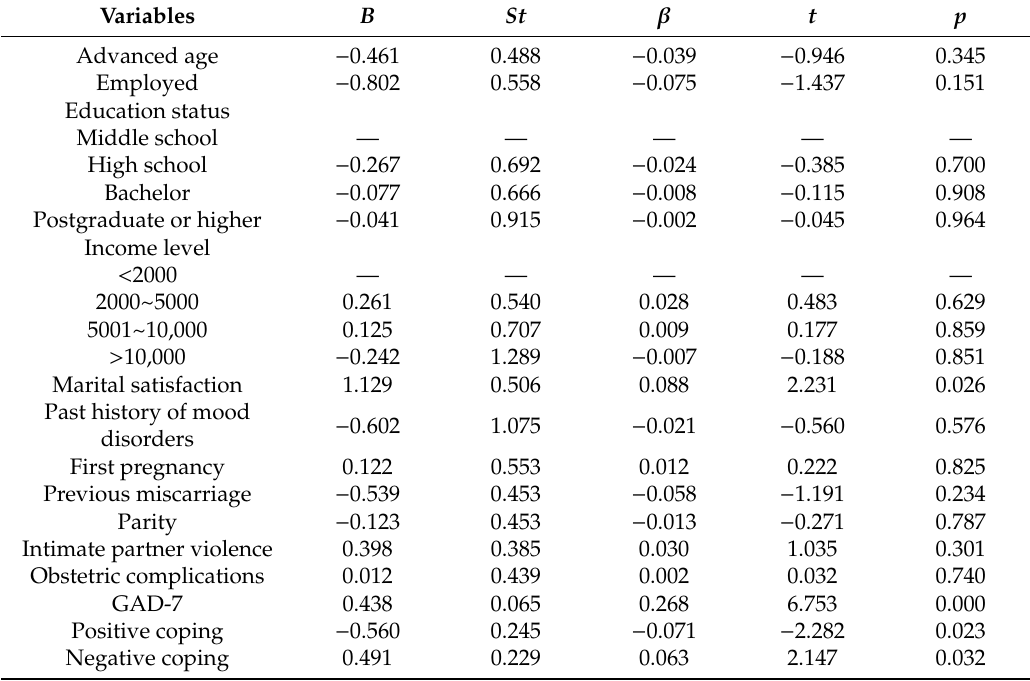
Table 6. Multivariate analysis of the association between coping and postpartum